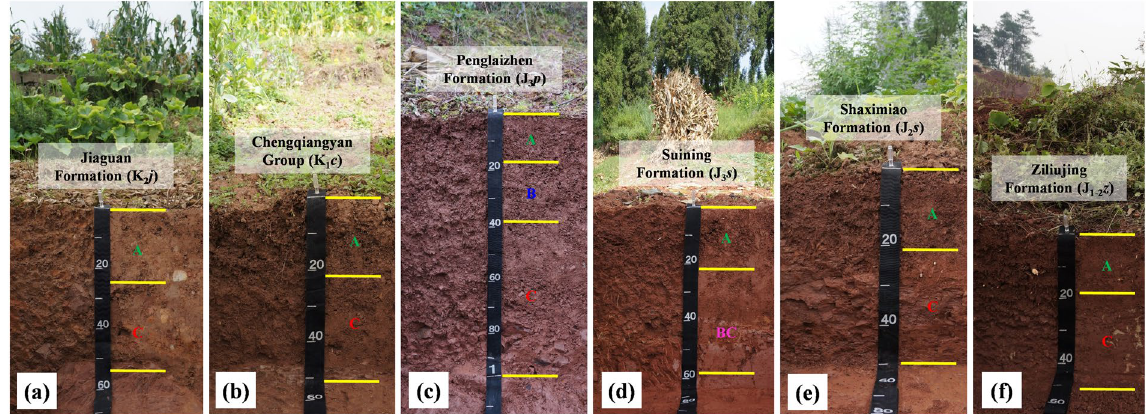
Figure 4. Soil profiles developed from different purple rocks. A, B, BC, and C denote the A horizon, B horizon, BC horizon, and C horizon,